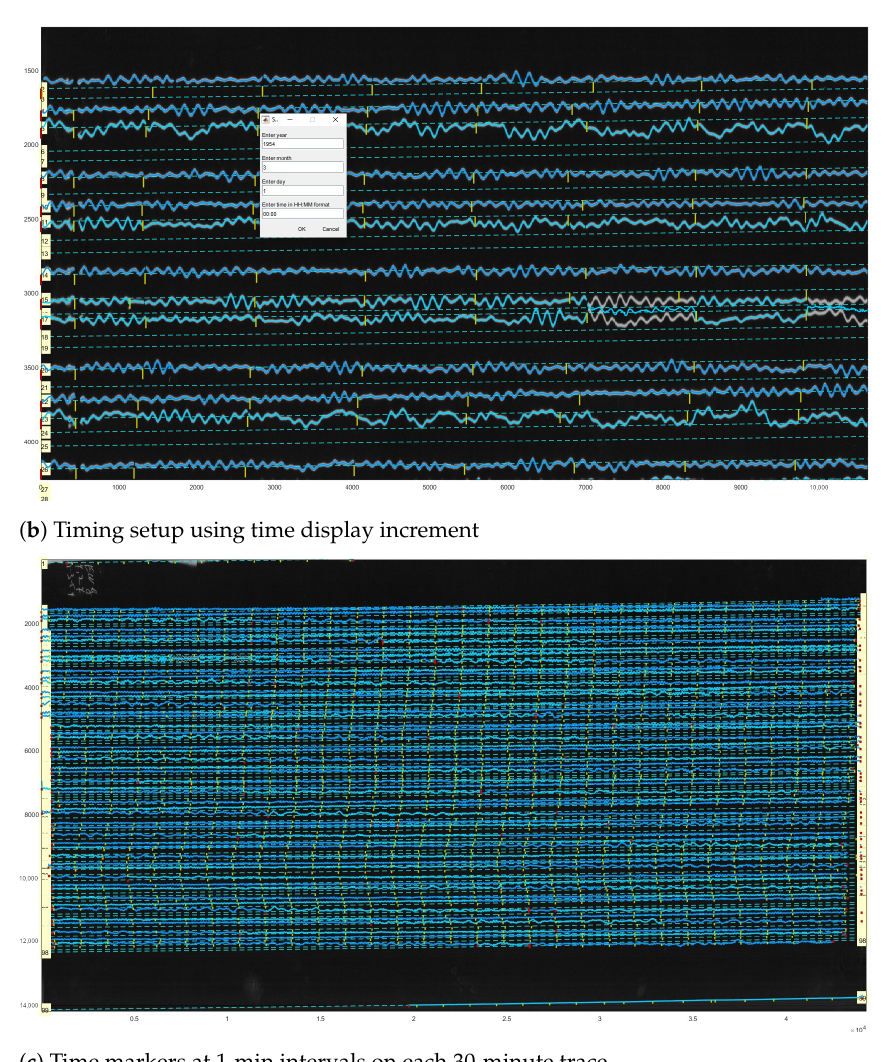
Figure 18. Seismogram image with adjusted timing. Here: UCC19540311Gal_E_0727.mat. The duration for the most of the lines was 30 min, and the seismograms were recorded by a drum of the seismometer in one day. So, we indicated the time between the gaps in seconds, and the program drew the gaps (visible yellow vertical dashed), Figure 18c and in the enlarged view, Figure 19. The time markers were visualised using the time gaps classified in a previous step and measured automatically using a threshold. Afterwards, the resulting data were exported into the MATLAB format, and saved as the .mat files. In MATLAB environment, the vector files were opened, checked and overlaid over the scanned TIFF image, respectively. The resulting files converted into MATLAB contained vector lines as traces, that is, included information received in DigitSeis. The converted file included the vectorised image with traces, its classification structure with segments and parts of the lines and time gap breaks. Therefore, a special value of the DigitSeis consists in its compatibility with MATLAB and possibility of further reuse of the processed files in other tools, such as Python. In this way, the vectorising workflow that we performed using DigitSeis is a continuous procedure can be smoothly integrated and exported to another software as a stepwise chain of the separated